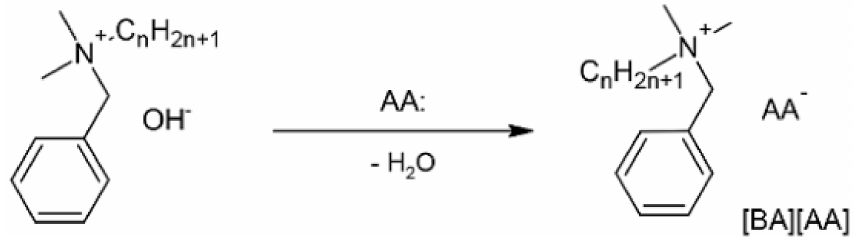
Figure 7. Schematic preparation of benzalkonium [BA] amino acid [AA] salts. Adapted from